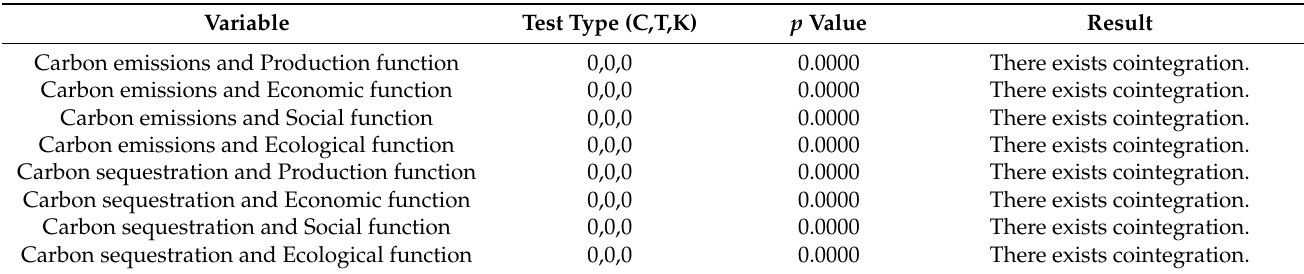
Table 4. Results of the panel cointegration test.